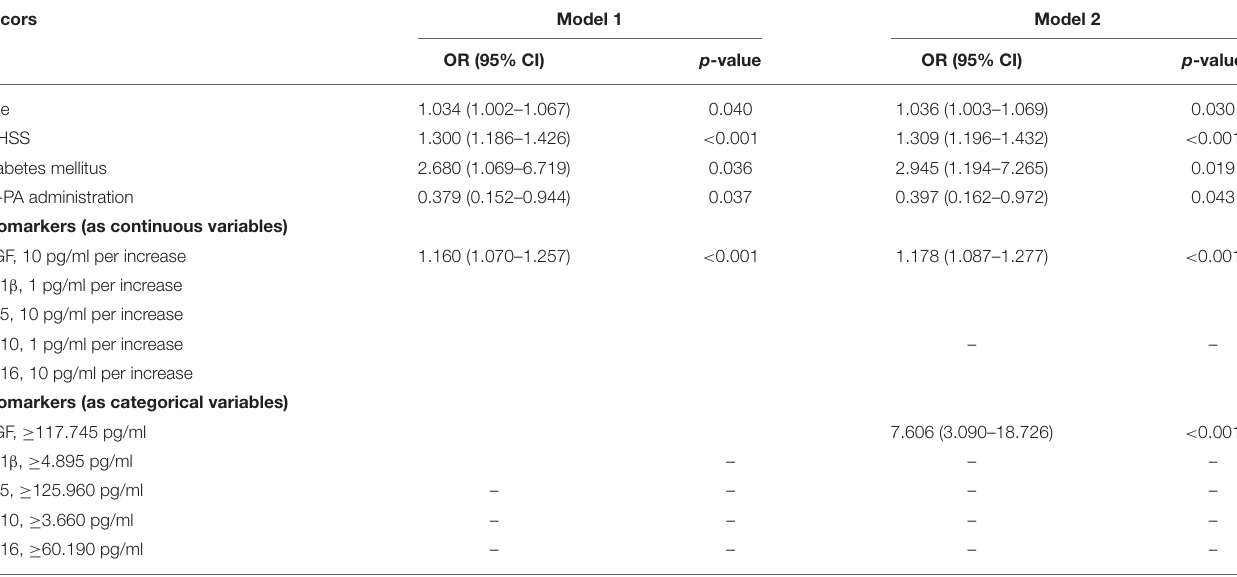
TABLE 2 | Univariable and multivariable logistic regression analyses depicting the associations of the four parameters and other baseline characteristics with unfavorable outcomes. Facors